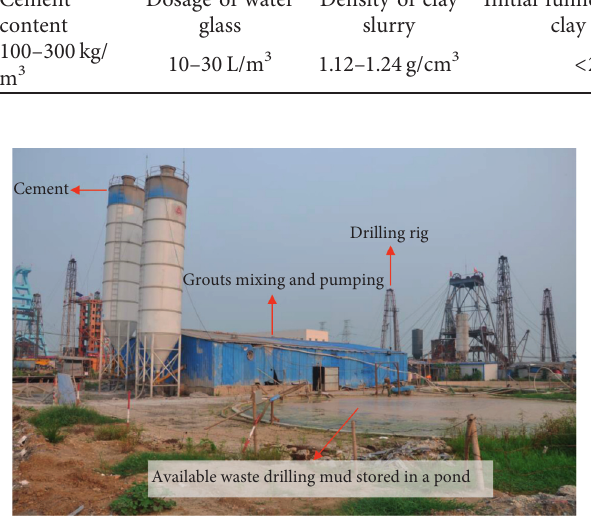
Figure 8: Grouting using the waste drilling